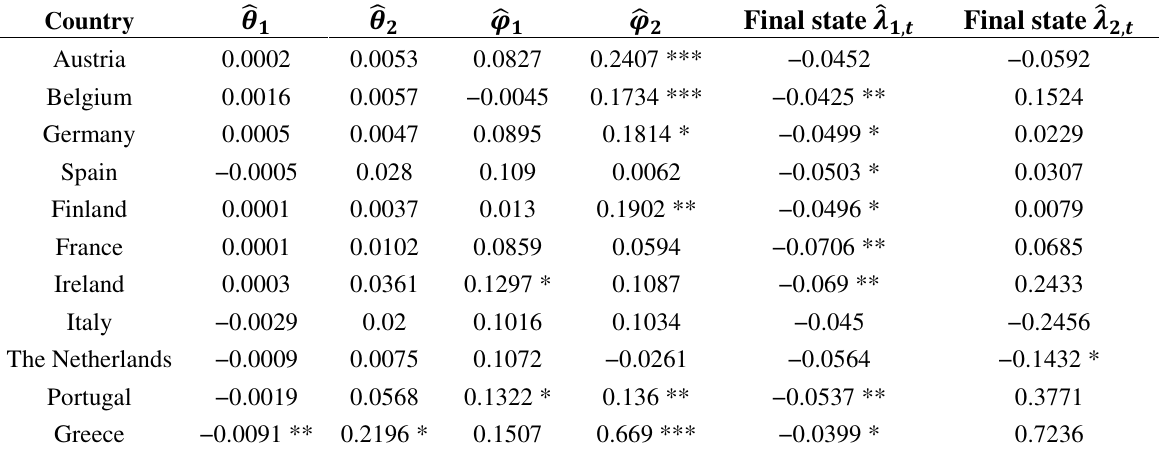
Table 6. Vector error-correction (VEC) state space representation with recursive estimation of the speed adjustment parameters–Estimation